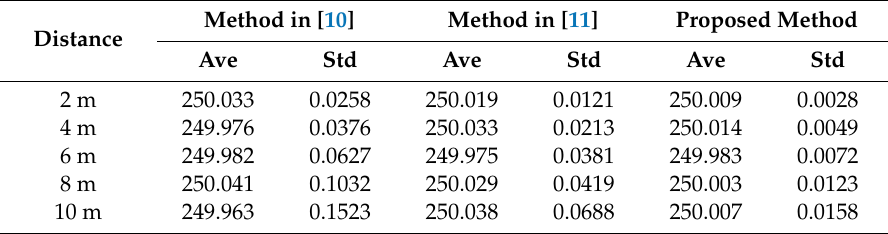
Table 6. Measurement results of 250 mm gauge with di ff erent calibration results. The meanings of the abbreviations Ave and Std are the same as in Table 4